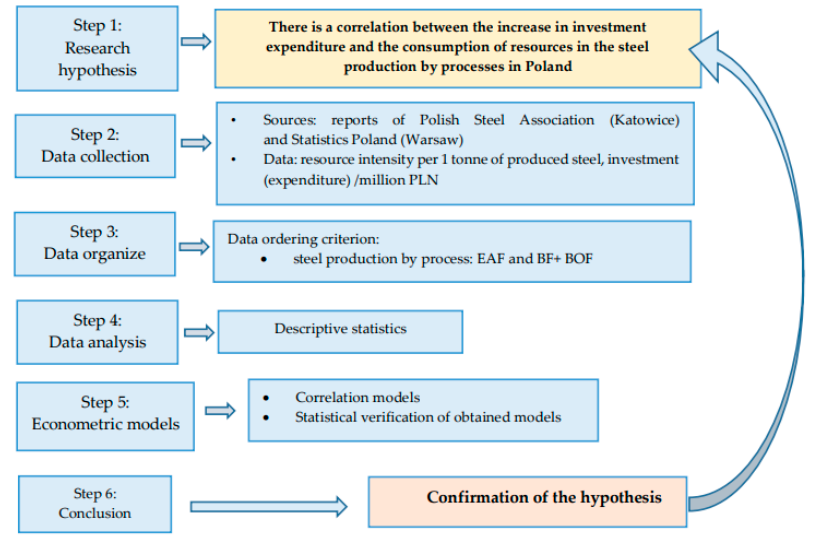
Figure 2. Research methodology.